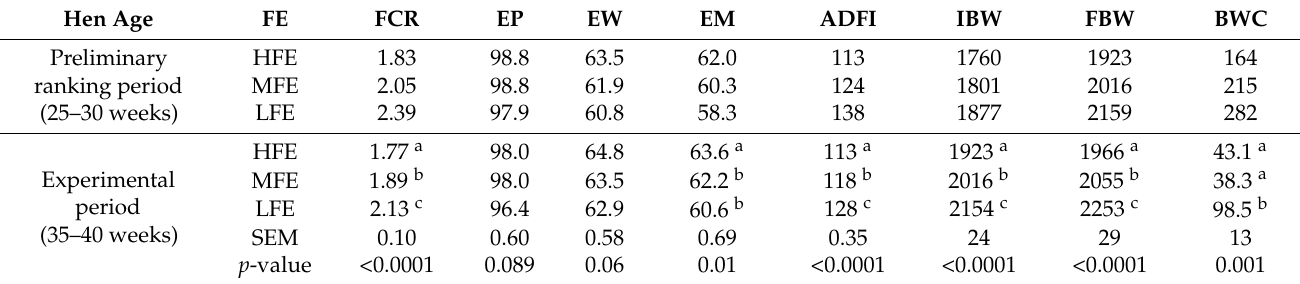
Table 1. Average performance variables of individual ISA Brown hens ranked based on FCR during the preliminary ranking period (25–30 weeks) and their subsequent performance in follow up experimental period (35–40 weeks), n = 48 hens per FE